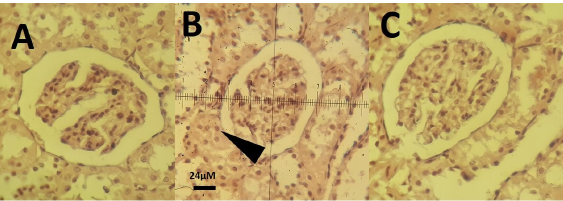
Figure 2 . Periodic Acid-Schiff (PAS) Staining of Kidney Sections; A: kidney section of a normal control rat, B: lead-treated rat; arrow shows narrowing of proximal tubules, C: micrograph of a lead- intoxicated rat after treatment with selenium nanoparticles. (H & E staining Microscopic magnification × 40) bar= 24 µm.